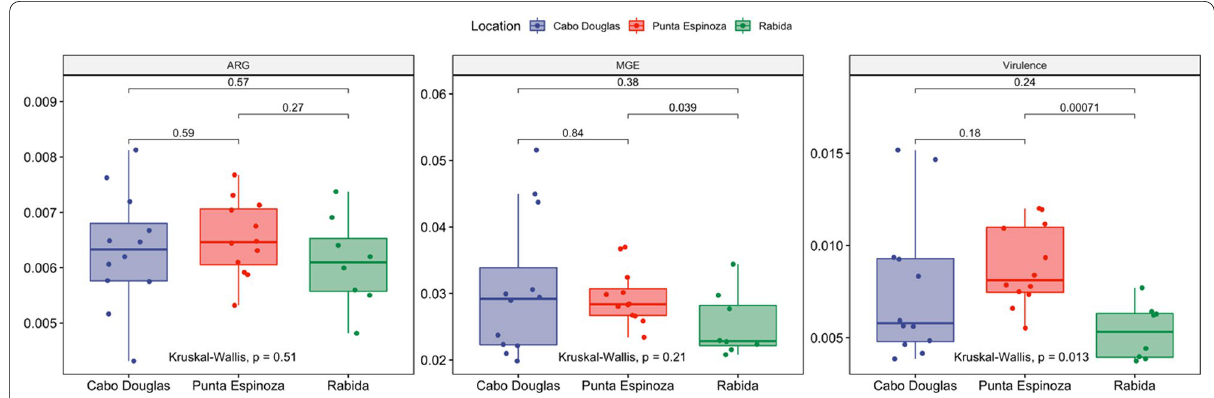
Fig. 6 Resistome, mobilome and virulome normalized proportion in the marine iguana’s gut